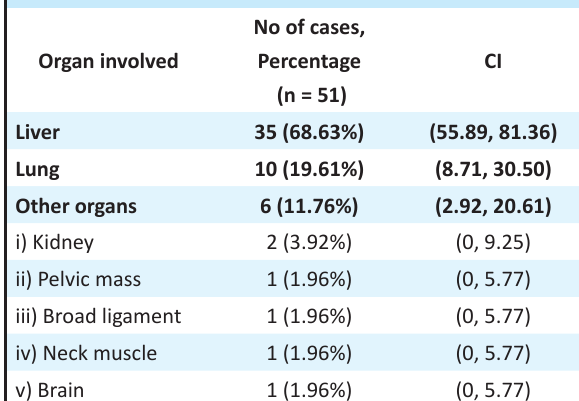
Table 3. Distribu ti on of cases according to